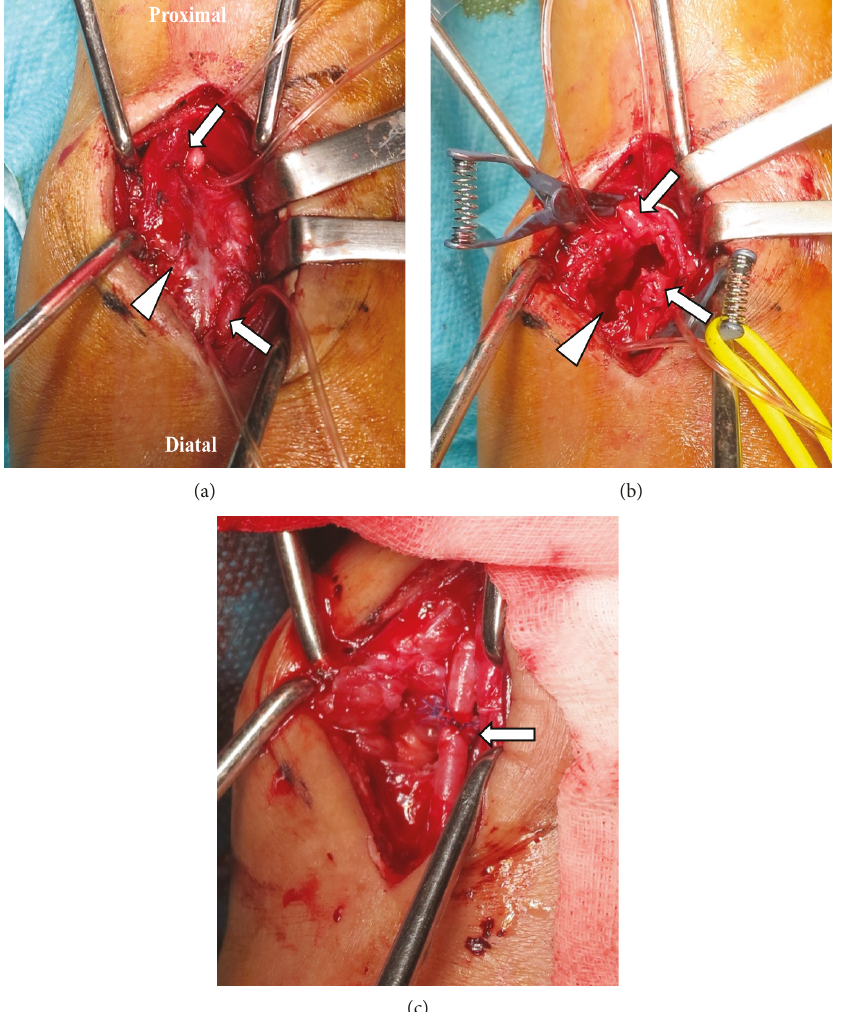
Figure 5: Photographic images taken during repair of the perforating peroneal artery injury. (a) Pseudoaneurysm (arrow) caused by disruption of the perforating peroneal artery wall on the anterolateral side of the ankle joint. Arrow indicates the main trunk of the perforating artery proximally and distally. (b) Pseudoaneurysm is cut (arrowhead) followed by removal of the hematoma-like content within the pseudoaneurysm. Arrow indicates the main trunk of the perforating artery proximally and distally. (c) Repair of the injured perforating peroneal artery wall using end-to-end anastomosis (arrow), without compromising blood supply to the